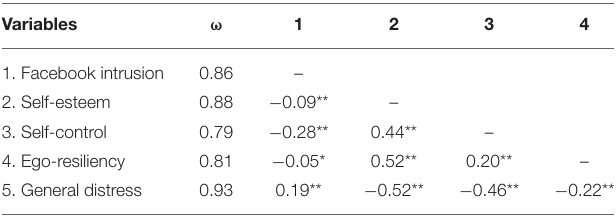
TABLE 1 | Reliability of the scales and within-level correlations between latent variables.